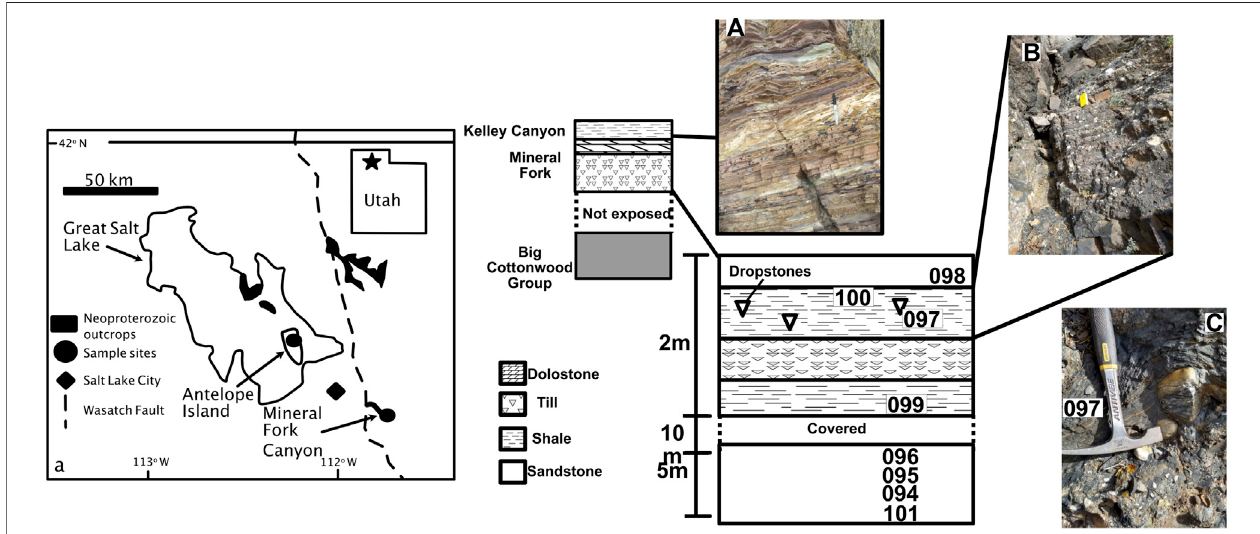
FIGURE 1 | Generalized map showing outcrop area of Neoproterozoic strata in Utah, United States. Map is after Crittenden et al. (1983) and (Young, 2002). Generalized cross section is shown, with detail of Mineral Fork Canyon showing sample locations. Photo (A) shows Kelley Canyon Formation, and (B) and (C) show outcrop photos from Mineral Fork Canyon. Samples were taken from fi nely laminated units away from draping, as seen in photo